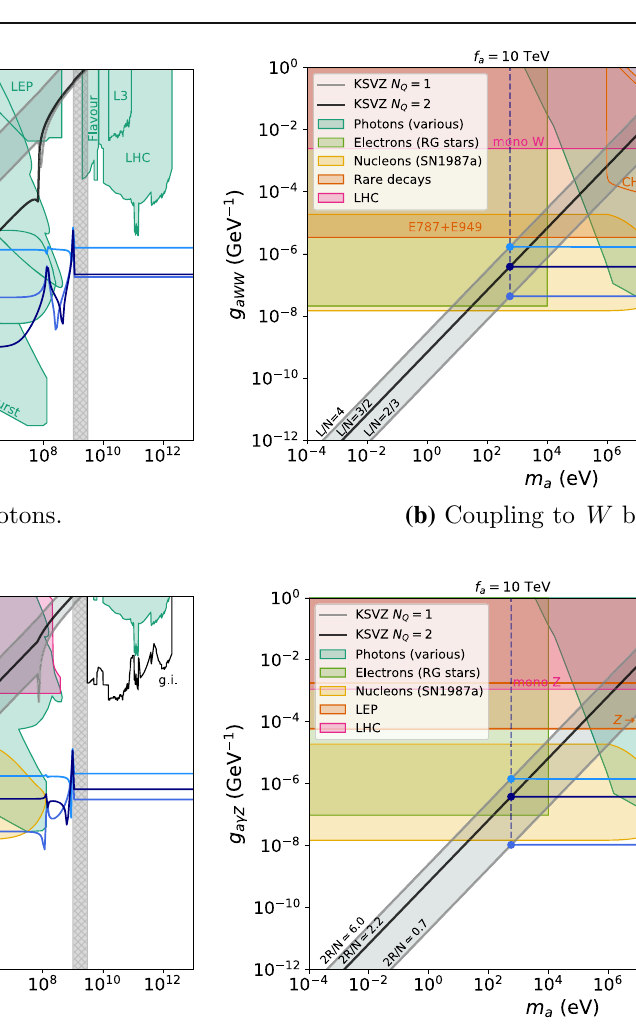
Figure 4b–d respectively for g WW , g ZZ and g γ Z are